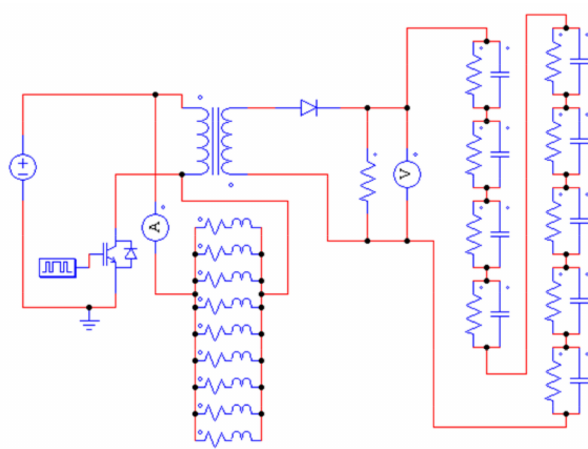
Figure 8. The circuit simulation model of the fractional-order flyback converter.